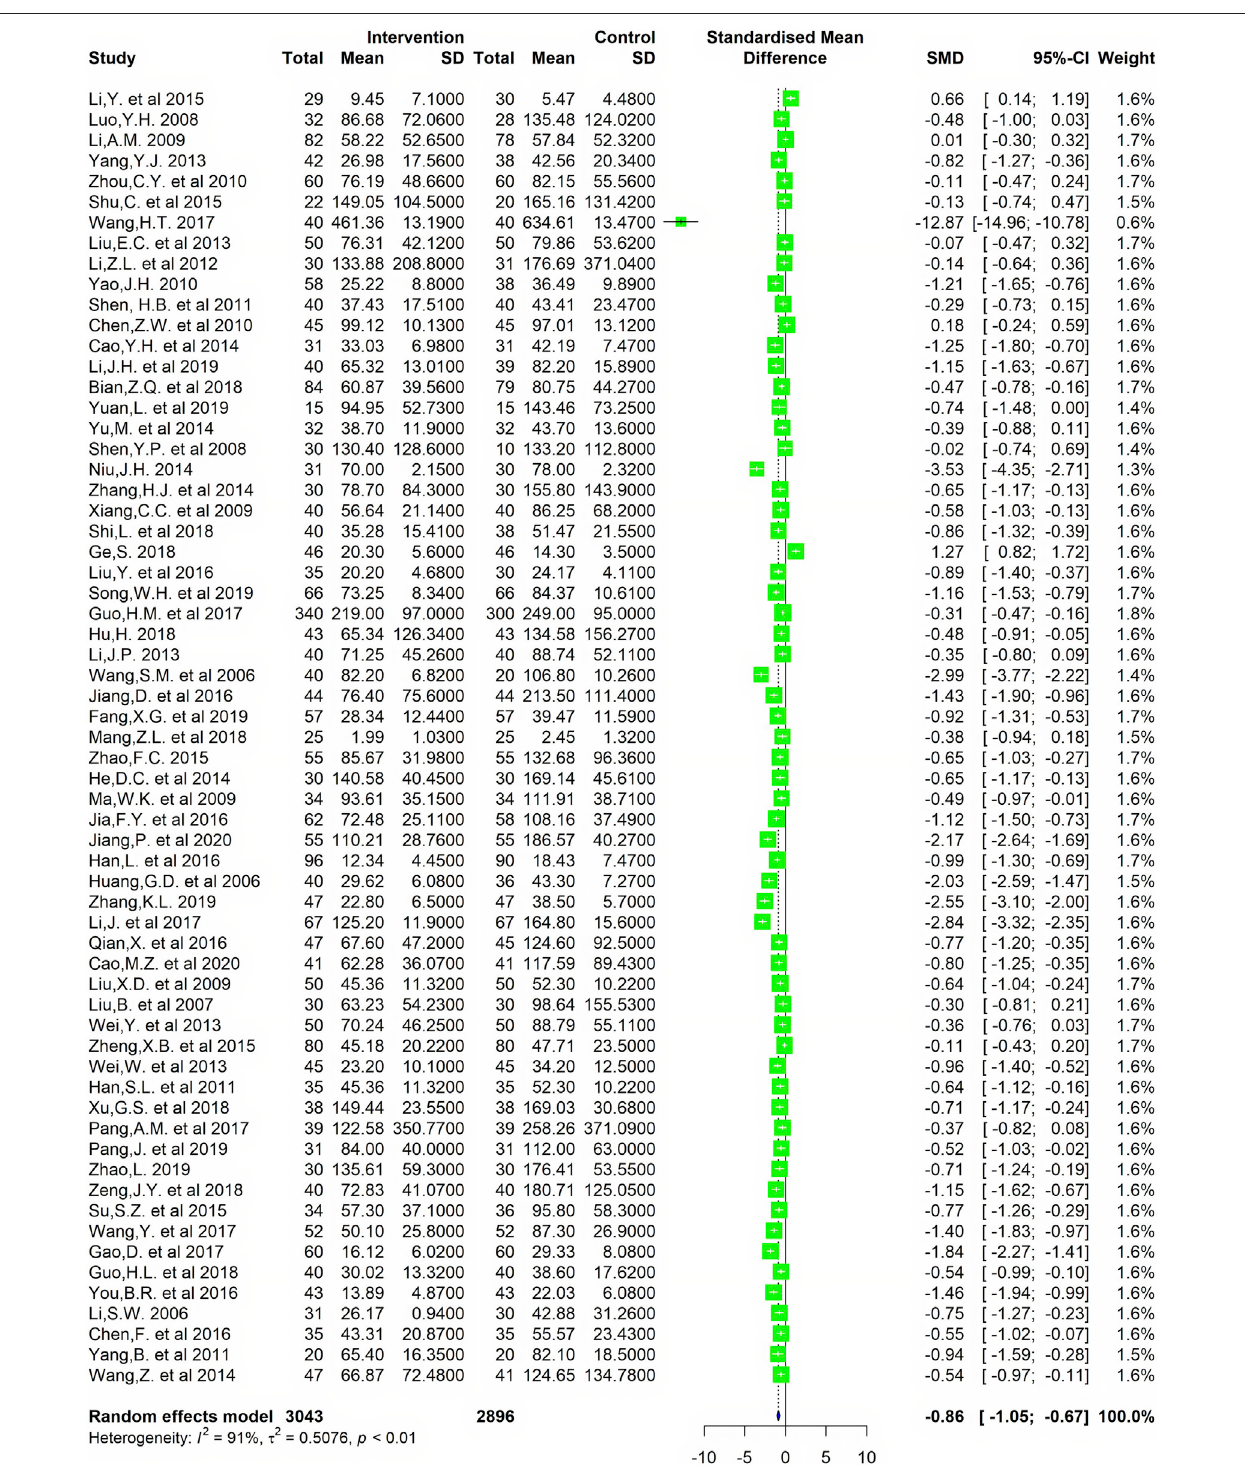
FIGURE 3 | Forest plot and meta-analysis of